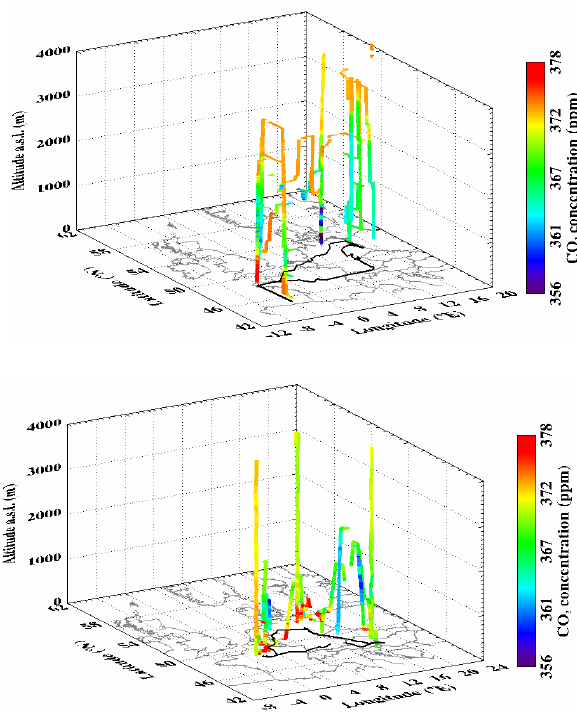
Fig. 4. CO 2 concentration 3-D distribution according to longitude, latitude and altitude. The flight patterns are projected on the longi- tude/latitude plan. (top: CAATER-1, bottom: